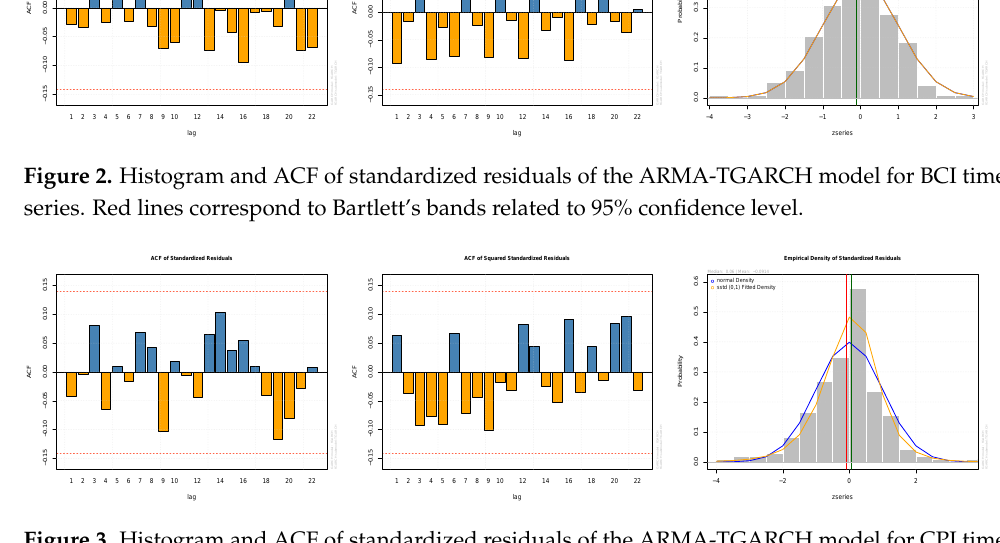
Figure 3. Histogram and ACF of standardized residuals of the ARMA-TGARCH model for CPI time series. Red lines correspond to Bartlett’s bands related to 95% confidence level.